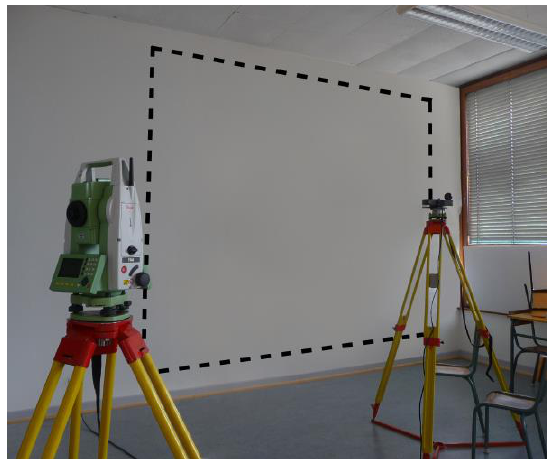
Figure 10. Depth calibration experiment (observed area in dotted